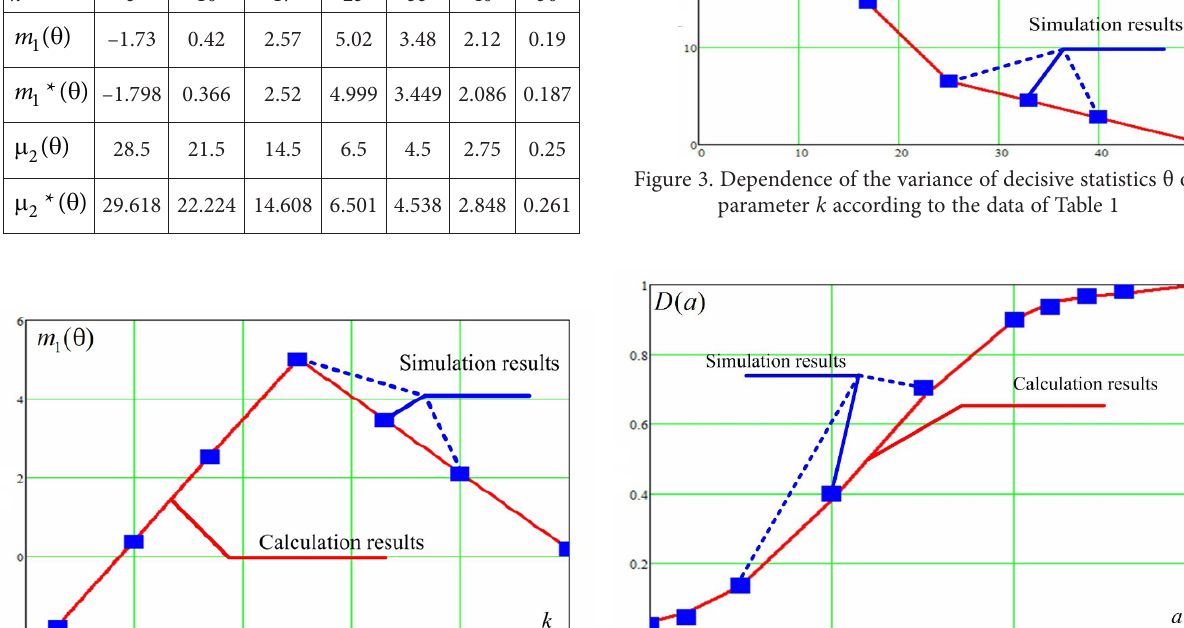
Figure 4. Characteristics of deterioration